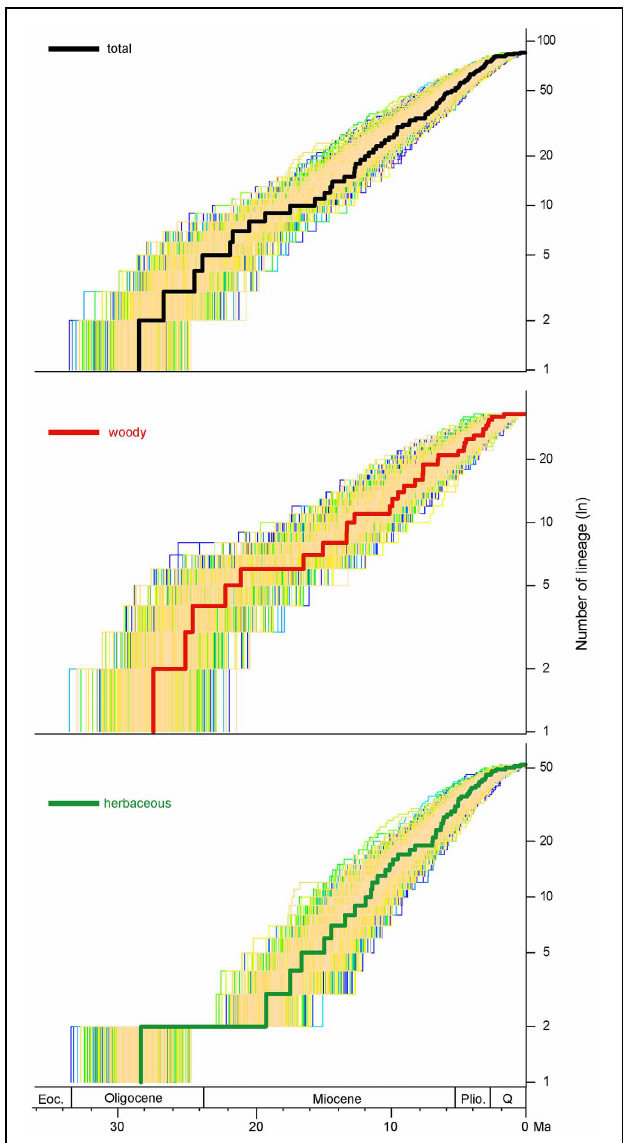
FIGURE 2 | Phaseoloid divergences through time, according to habit.